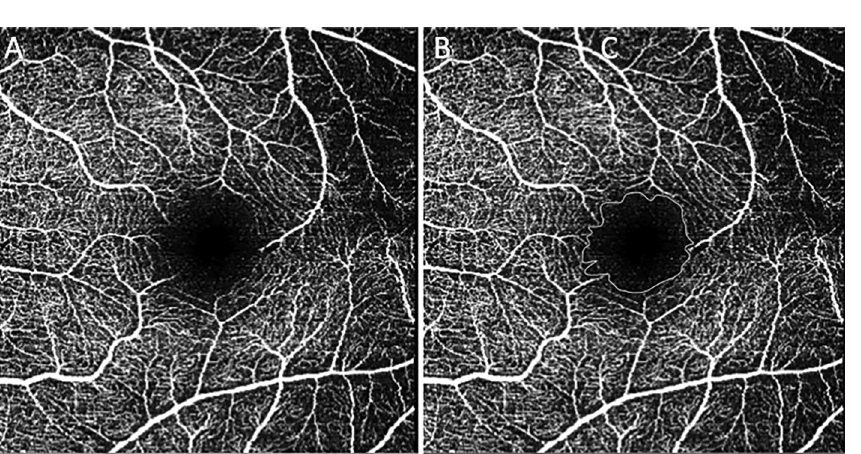
Figure 2. OCT-A images of the macula with the FAZ in the center showing the original ( A ) and the traced FAZ ( B